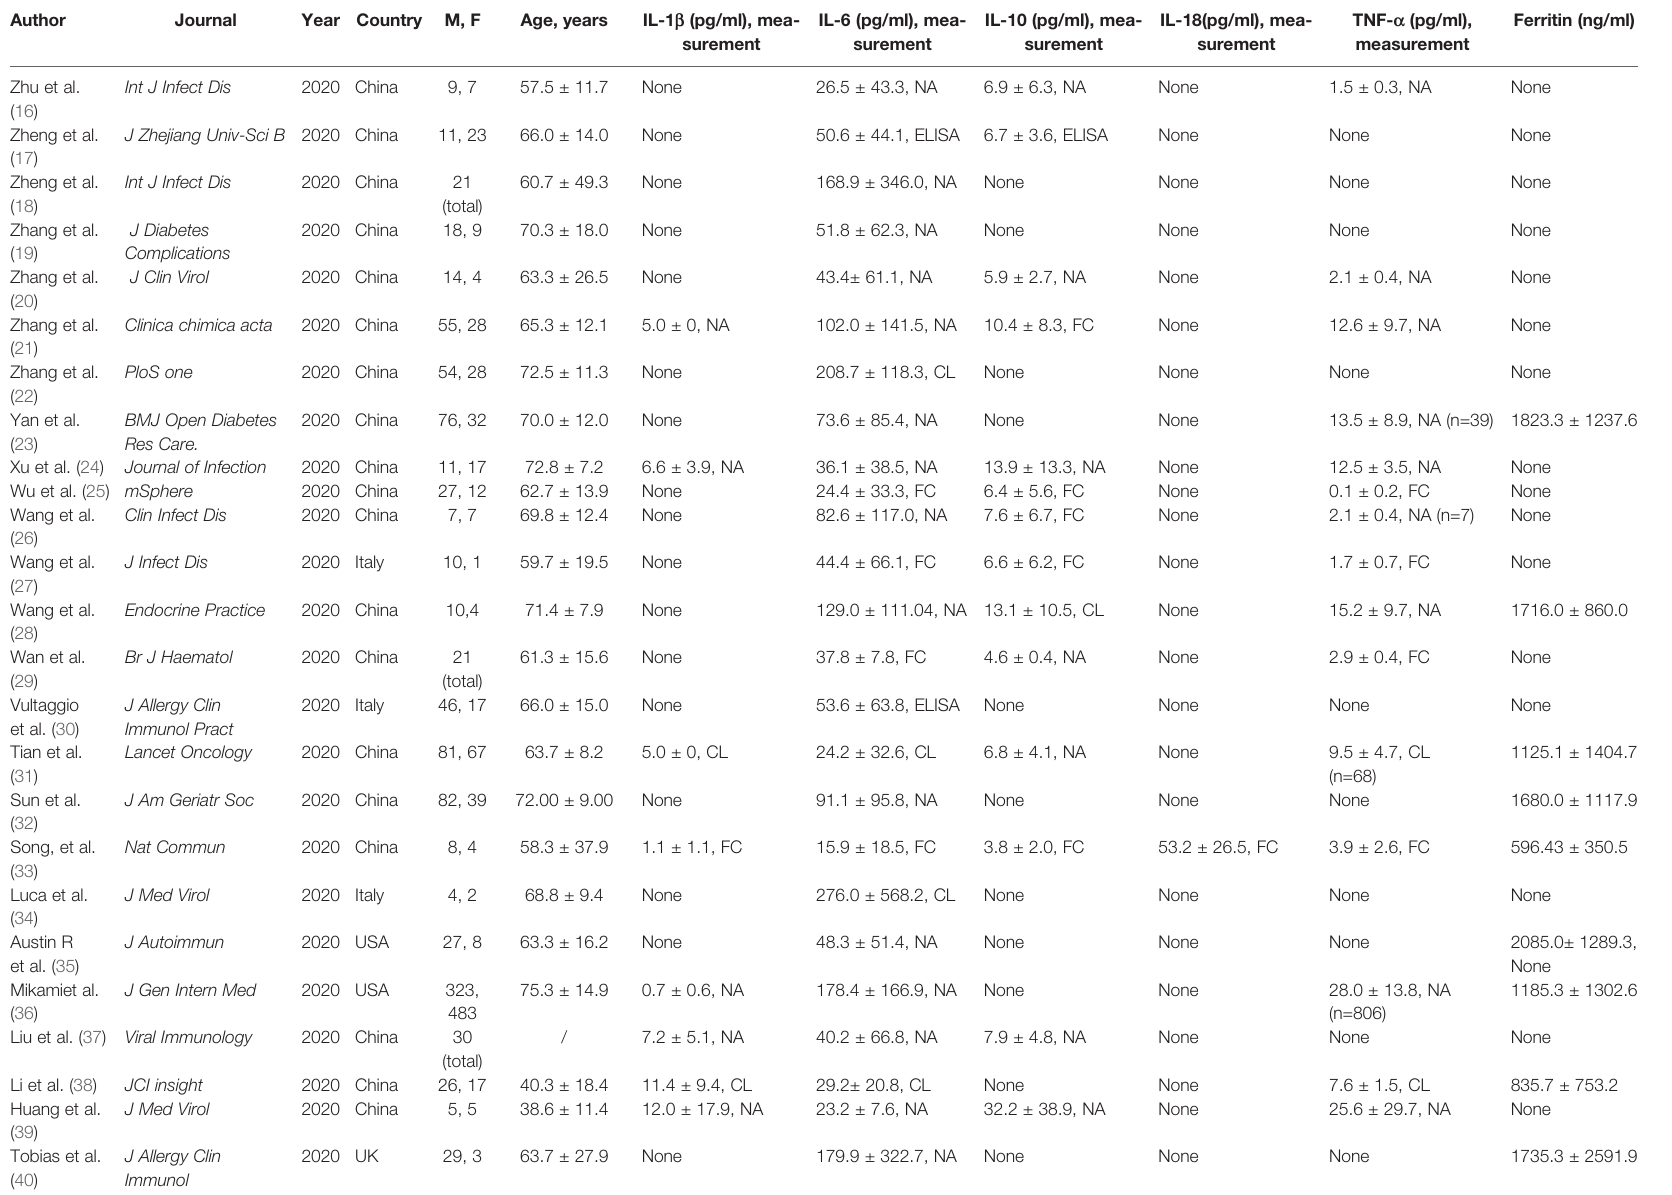
TABLE 1 | Summary characteristics of 33 studies that demonstrated the cytokine level in patients with COVID-19. Author